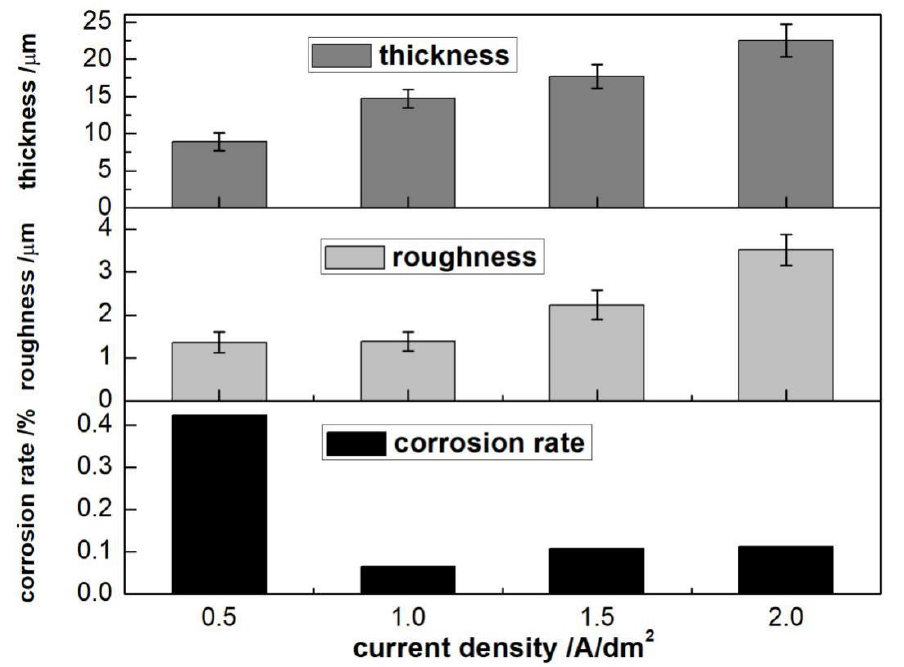
Figure 3. The values of corrosion rate, roughness and thickness at different current densities. Elec- trolyte compositions: 45 g/L NaOH, 50 g/L Na 2 SiO 3 , 90 g/L Na 2 B 4 O 7 . Electrical parameters: oxidation time 10 min; pulse frequency 100 Hz; duty cycle 10%.